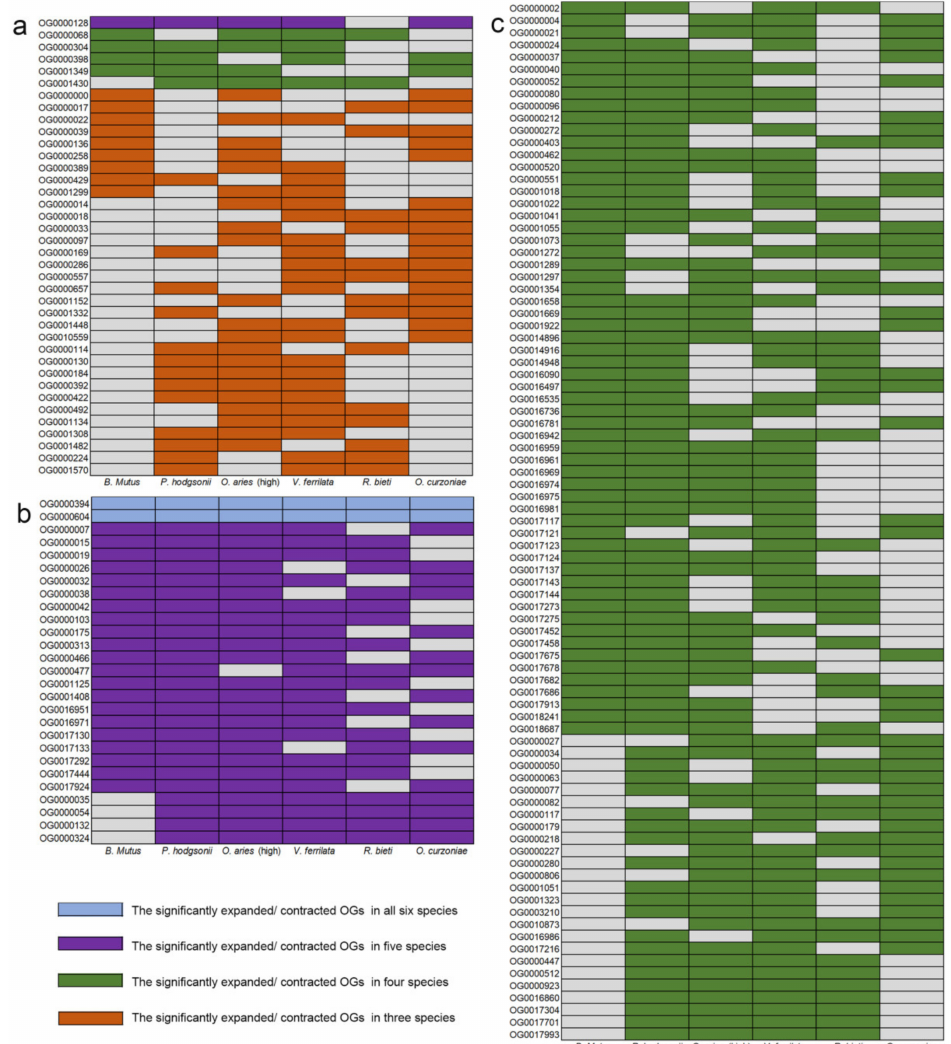
Figure 3. Gene families with significant expansions and contractions in at least three of the six high-altitude species. The gray squares indicate that there is no significant expansion or contraction of this gene family in this species. ( a ) Statistics of gene families with significant convergent expansions in at least three high-altitude species. ( b ) Statistics of gene families with significant convergent contractions in at least five high-altitude species. ( c ) Statistics of gene families with significant convergent contractions in four high-altitude